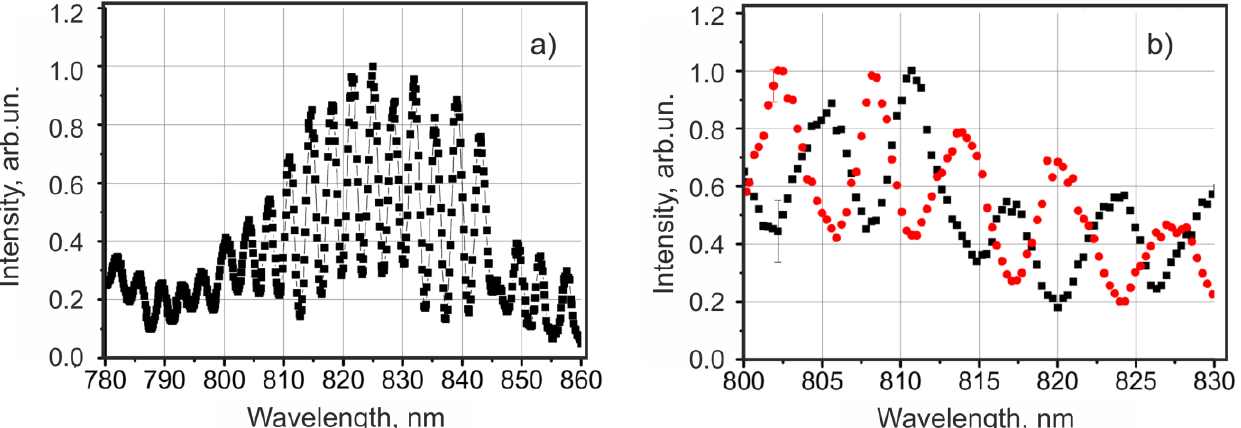
Figure 5. ( a ) Intensity spectrum of the diffracted beam passed through the porous quartz PhC of 0.2 mm long in the Laue geometry; ( b ) spectra of the transmitted (red symbols) and of diffracted (black symbols) beams under measured under the similar